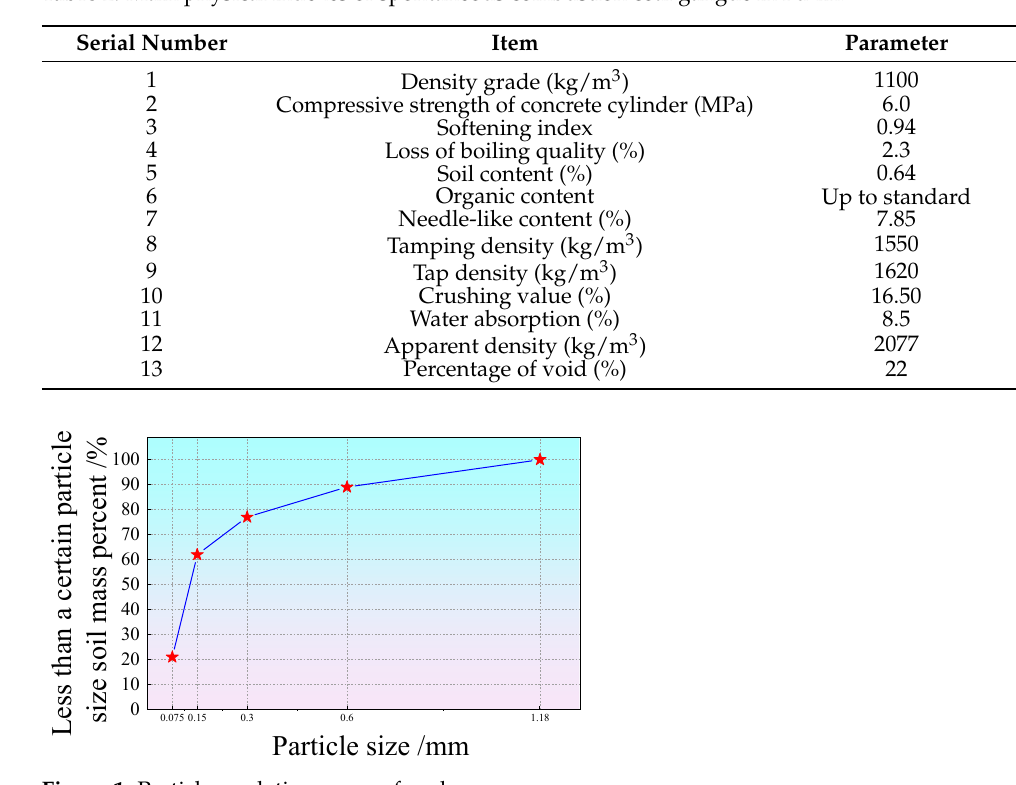
Table 2. Main physical indexes of spontaneous combustion coal gangue in Fuxin.